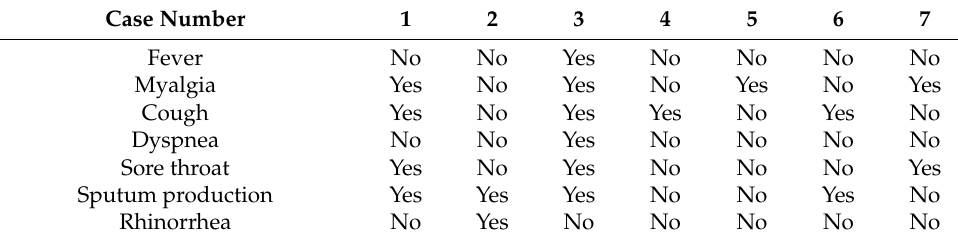
Table 2. Signs and symptoms of disease.